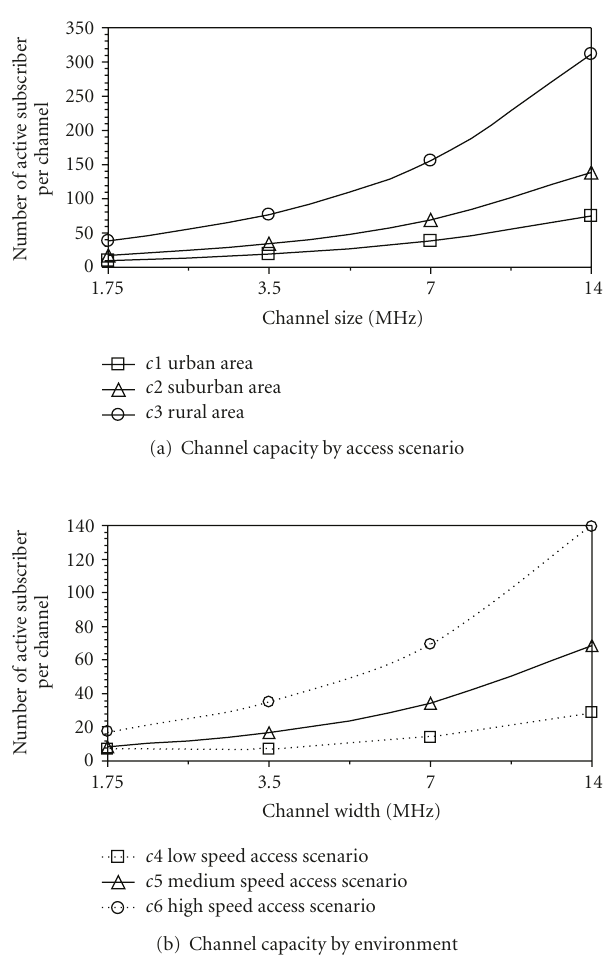
Figure 6: Channel Capacity of IEEE802.16 by access rate and environment